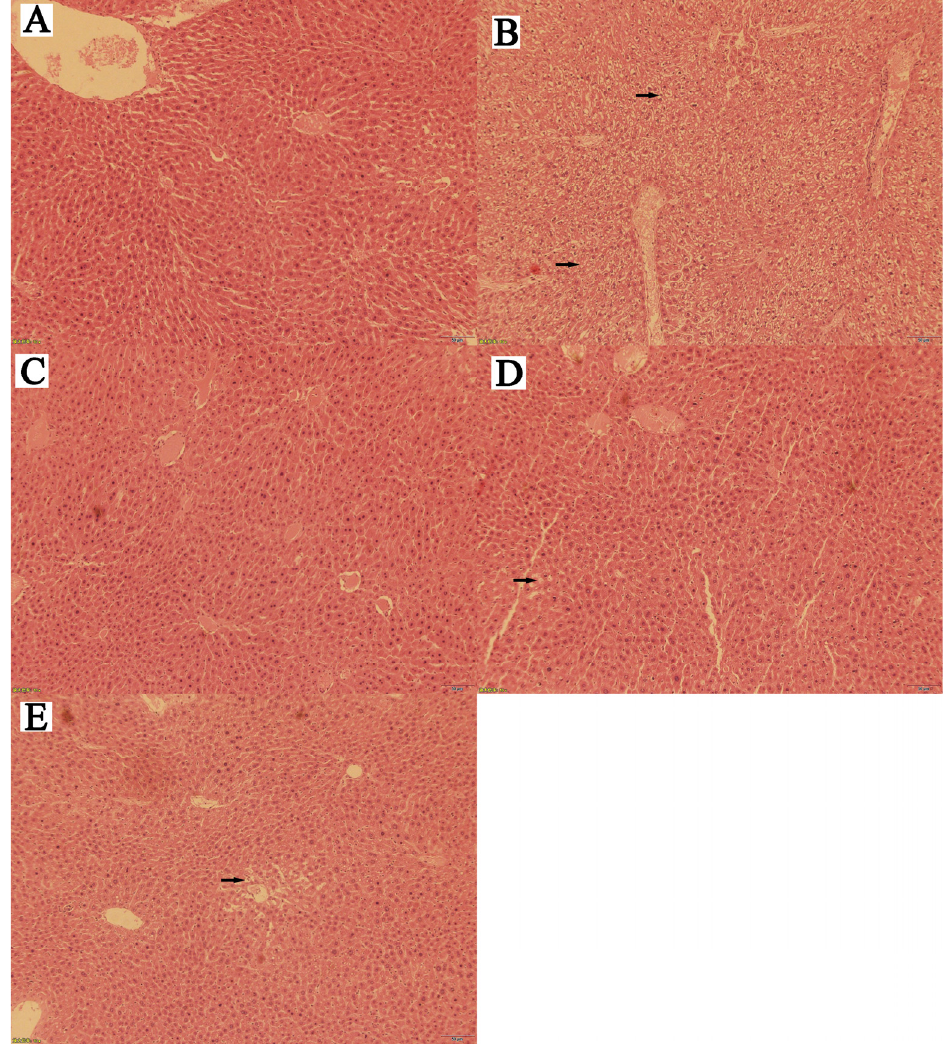
Figure 3. Effects of naringin on histopathological changes in mouse liver sections (the histopatho- logical analyses of mouse liver) (H&E staining; 400 × ). ( A ) Normal control, NC; ( B ) hyperlipidemia model group, HM; ( C ) high-dose group, HD; ( D ) medium-dose group, MD; ( E ) low-dose group,